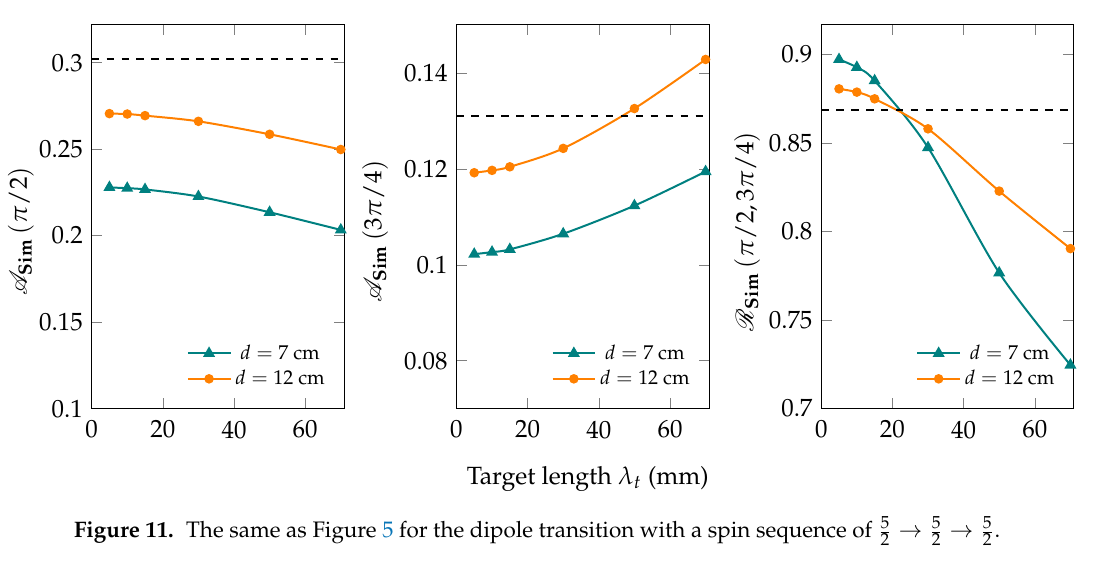
Figure 11. The same as Figure 5 for the dipole transition with a spin sequence of 5